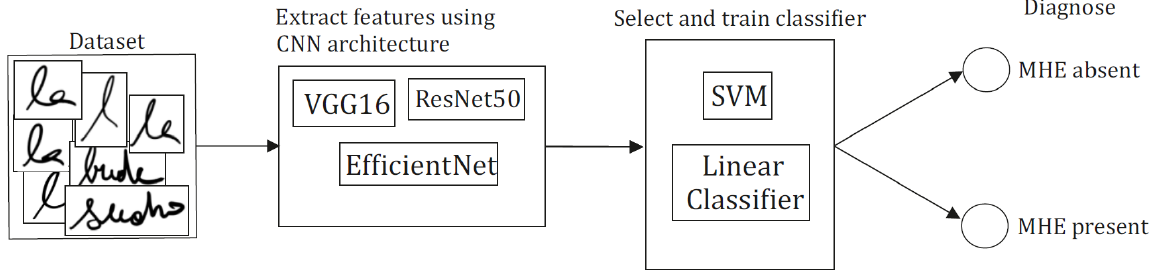
Figure 1. Convolutional neural networks (CNNs) are known for unprecedented performance in various tasks, including computer vision. Deep learning can directly select important features from training data, and it lowers the effort of tedious preprocessing and manual feature selection. Countless convolutional neural network architectures can be used, but they often share similar common concepts as convolutional, pooling, and dense layers. ResNet50 [60], EfficientNet [61], and VGG16 [62] are all considered the state-of-art. Representations can be reused either in linear classification head (group classification based on the value of a linear combination of the characteristics [63]) or traditional machine learning algorithms such as SVM (support-vector machine algorithm [64]), logistic regression, and many others.